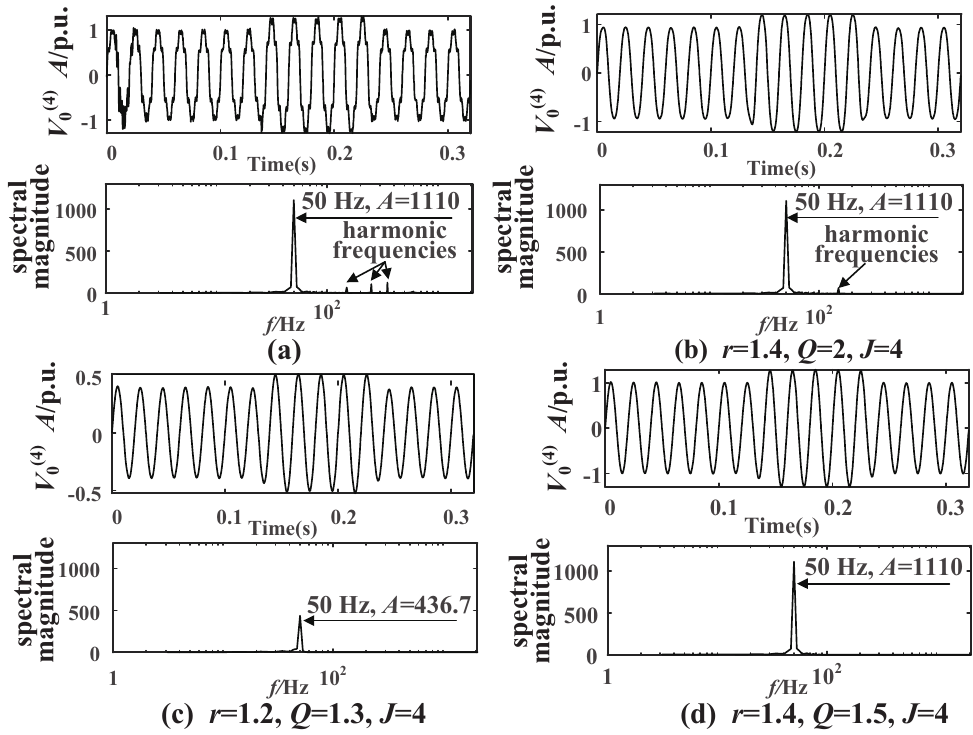
Figure 3. Analysis of fundamental frequency components’ extraction. ( a ) three different sets of ( Q , r ) and fixed J are used to decompose the PQ disturbance signal; ( b ) V components; ( c ) the value of the spectral magnitude of V component correctly decomposed from the input